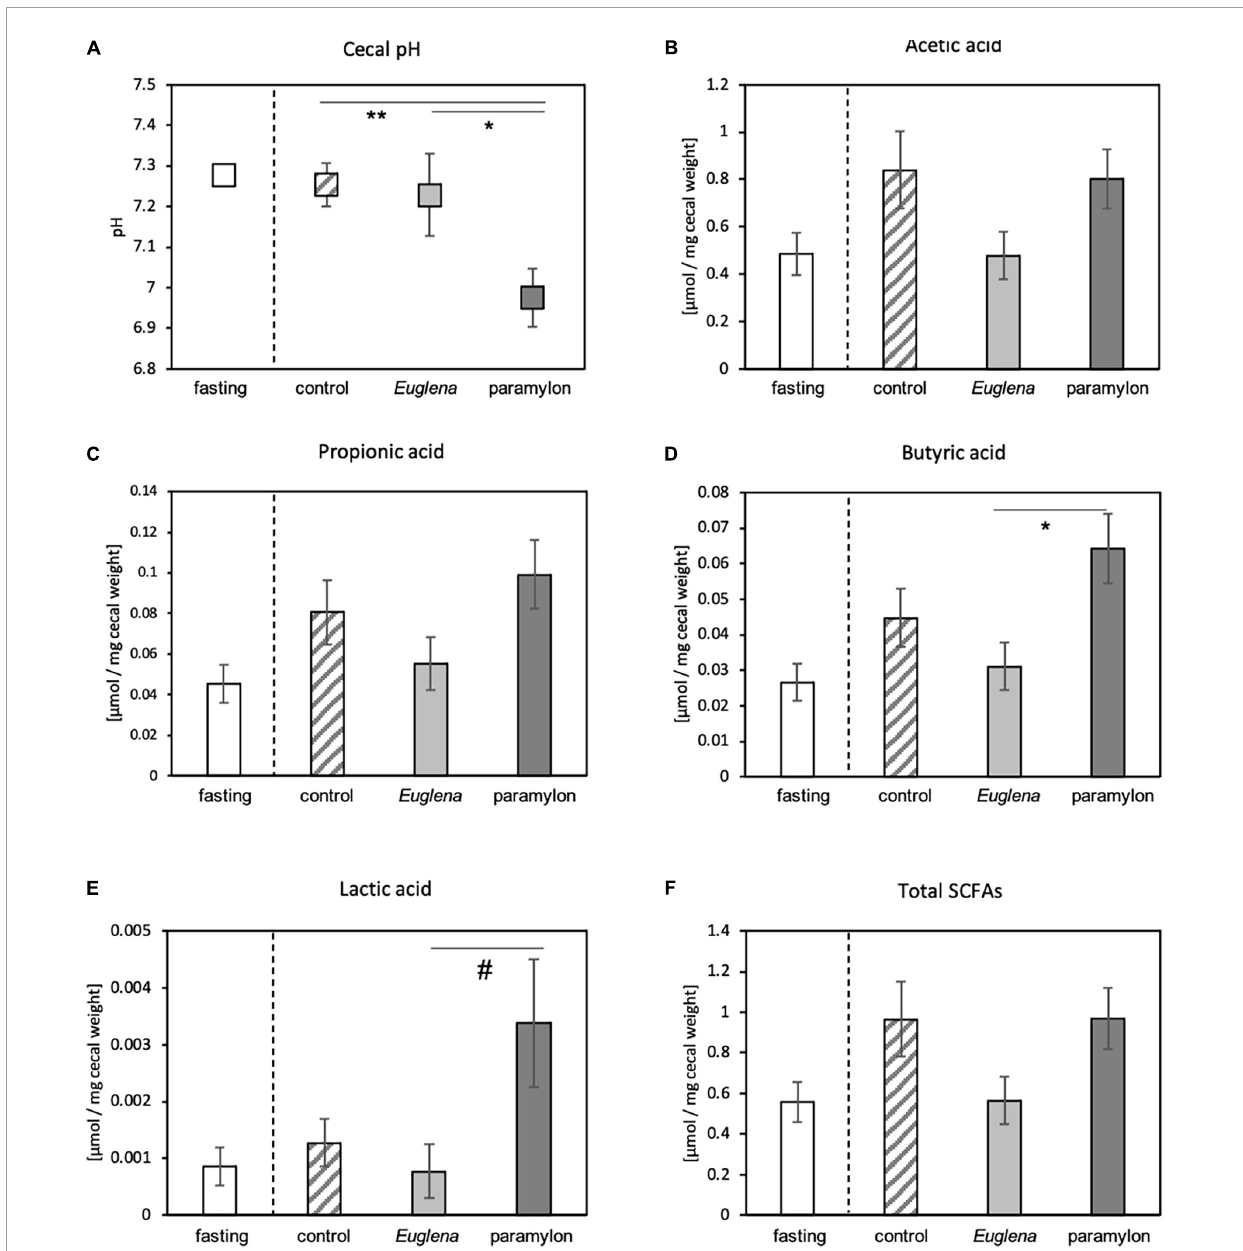
FIGURE3 Effects of paramylon diet on cecal pH and the concentration of butyric acid in mice. (A) Cecal pH. (B–F) Concentrations of SCFAs in the cecal content including (B) acetic acid, (C) propionic acid, (D) butyric acid, and (E) lactic acid; (F) total SCFA levels. Values are expressed as mean ± SEM ( n = 8). * p < 0.05, ** p < 0.01 (one-way ANOVA with Tukey’s multiple comparisons test). # p < 0.05 (Kruskal-Wallis test with Dunn’s multiple comparisons